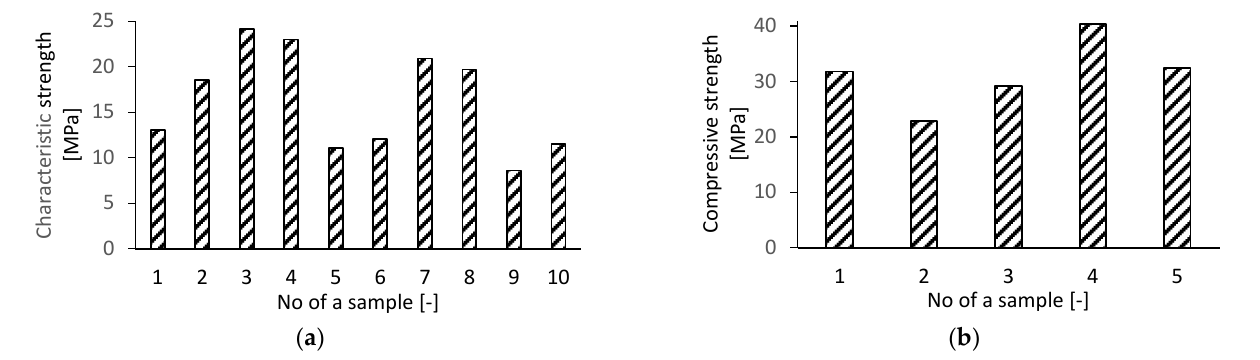
Figure 10. Results of concrete strength parameters: ( a ) hardness using Schmidt hammer ( b ) compressive strength using SATEC machine (based on the information provided in [72]) .